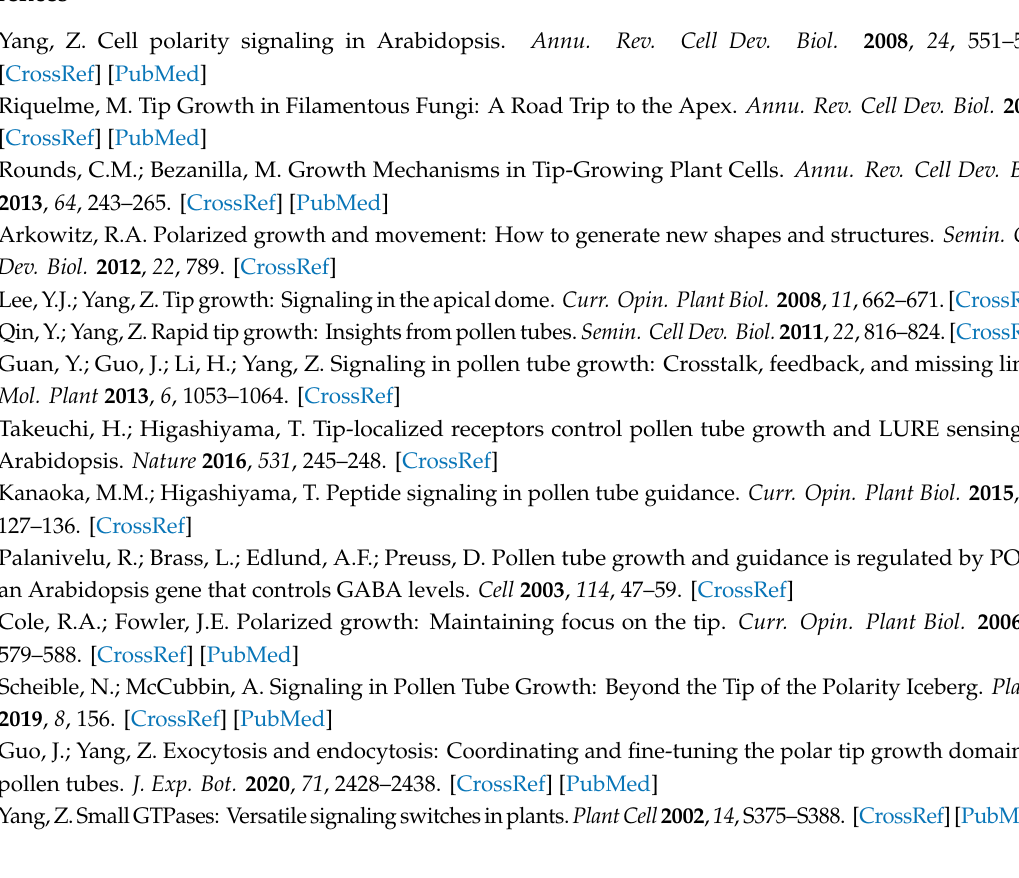
Table S2. The information of 32 screened mutants from the CS27943 library. Figure S1: Analysis of expression levels of top 400 ROP1-associated genes in di ff erent tissues of Arabidopsis. Figure S2: The T-DNA insertion site and DNA genotyping data with identified primers for 4 T-DNA mutants background. Figure S3: The identified 35 ROP1 interactors from the STRING